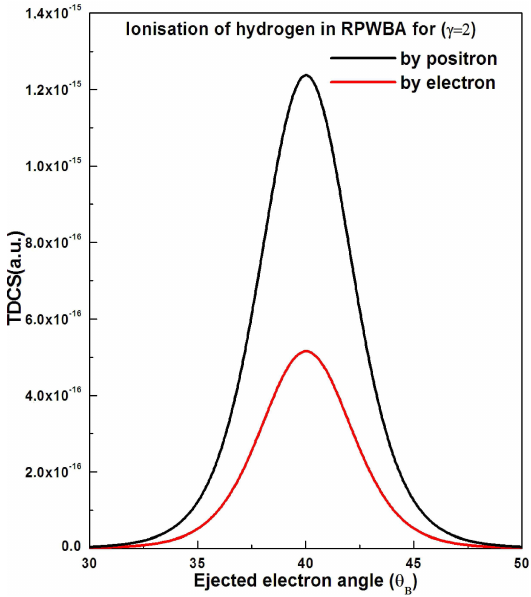
Figure 6. The incident kinetic energy is T i = 510.999 keV, ejected electron kinetic energy is T B = 255.4995 keV and geometric parameters ϕ i = ϕ f = 0 ◦ , ϕ B = 180 ◦ , θ i = 0 ◦ and θ f = 45 ◦